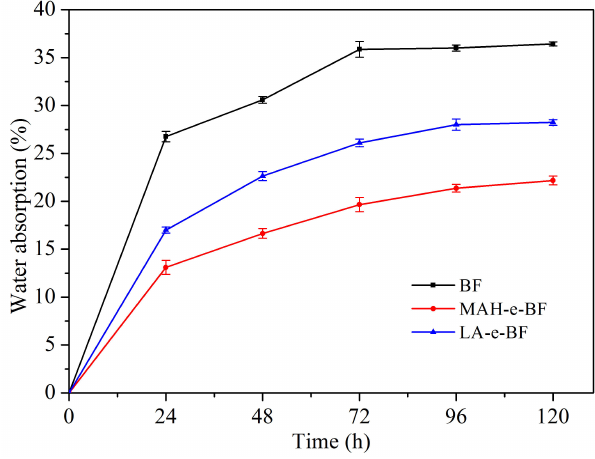
Figure 6. Scatter diagram of water absorption change of BF, MAH-e-BF, and